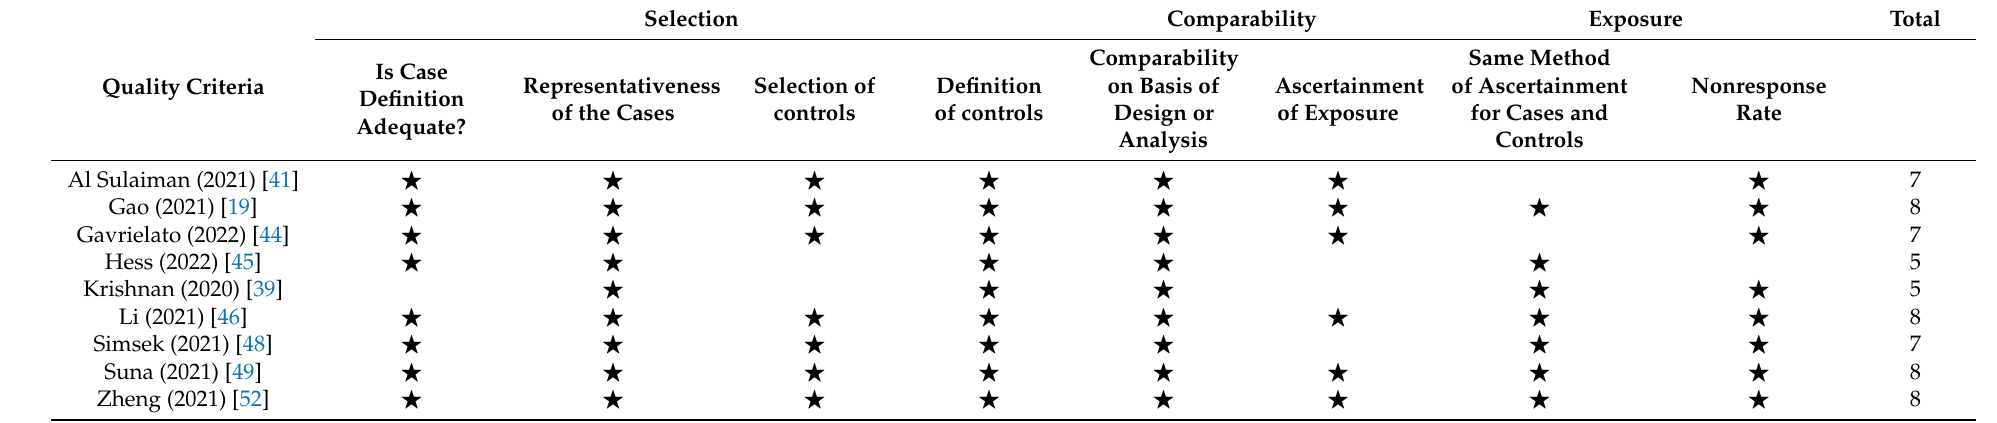
Table 2. Quality assessment by the Newcastle-Ottawa quality assessment scale.